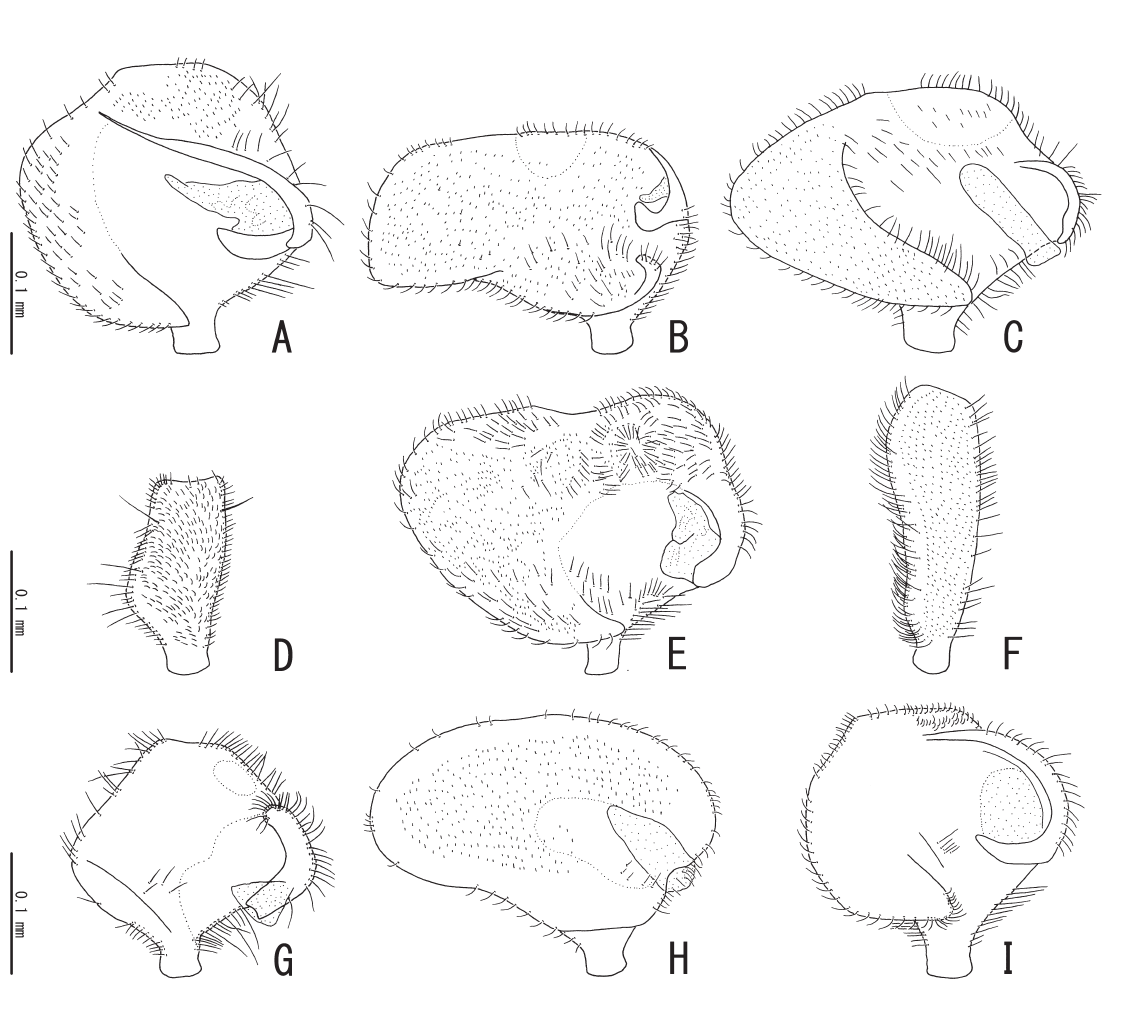
Fig. 8. Male antennomere III of Laius spp. A . Laius baliensis sp. nov. (paratype). B . L.